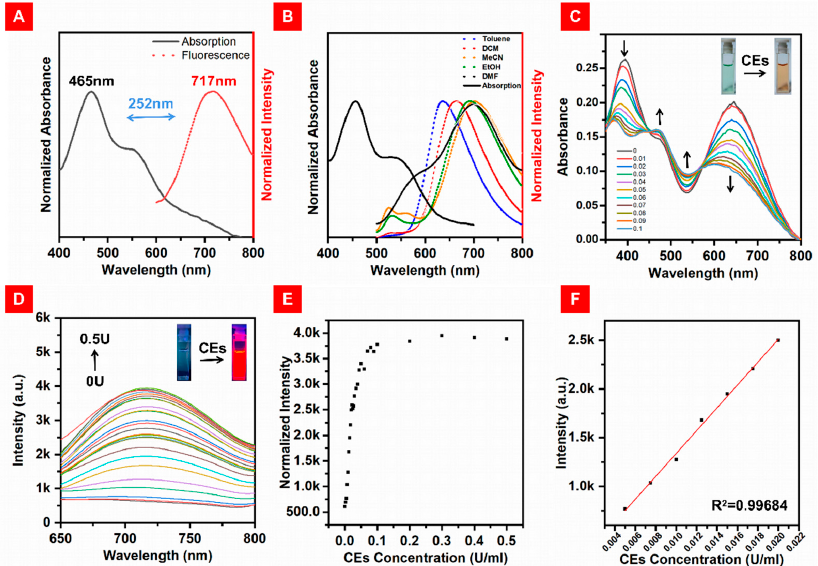
Figure 1. ( A ) Normalized absorption spectra (black solid line) and fluorescence spectra (red dotted line) of DBPpy in DMF:HEPES ( v:v = 4:6, pH = 7.4). ( B ) Normalized fluorescence spectra (dotted lines) of DBPpy in different solvents and the absorption spectrum (solid line) of DBPpy in DMF. ( C ) Absorption spectra of DBPpys (10 μ M) toward different concentrations of CEs in DMF:HEPES ( v:v = 4:6, pH = 7.4). ( D ) Fluorescence spectra of DBPpys (10 μ M) toward the concentrations of CEs from 0 U/mL to 0.5 U/mL in DMF:HEPES ( v:v = 4:6, pH = 7.4). ( E ) Fluorescence intensity of DBPpys (10 μ M) at 720 nm after reaction with the concentrations of CEs from 0 U/mL to 0.5 U/mL in DMF:HEPES ( v:v = 4:6, pH = 7.4). ( F ) Linear fitting curve of the fluorescence intensity of DBPpys at 720 nm (10 μ M) toward the concentrations of CEs from 0.005 U/mL to 0.02 U/mL.